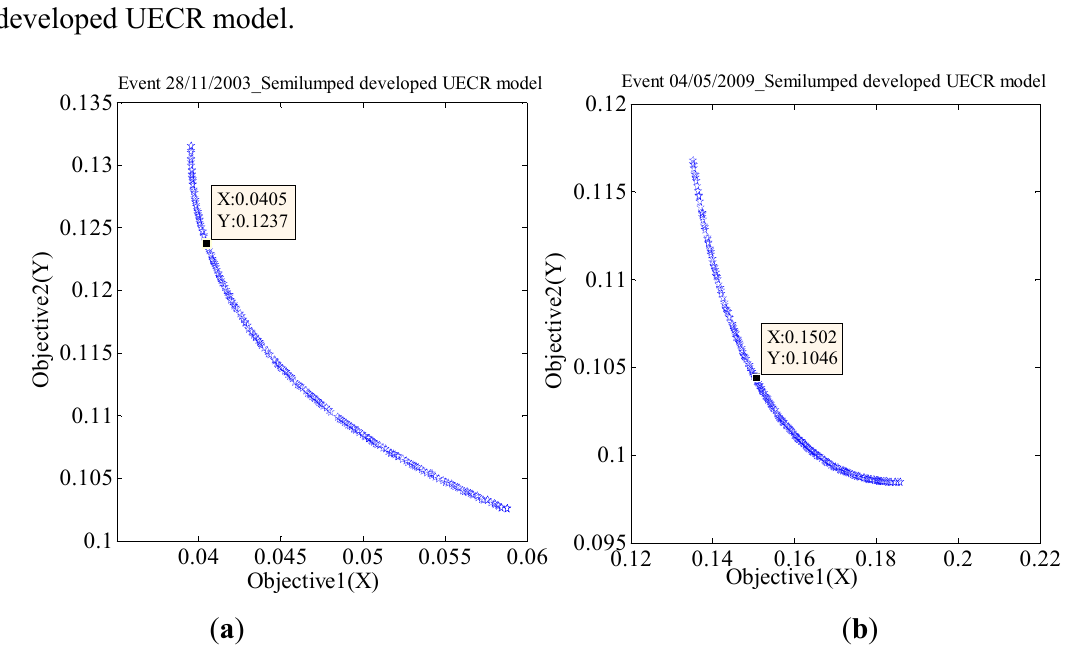
Figure 6. Pareto front and best compromise solution. ( a ) Event 28 November 2003_Semilumped developed UECR model; ( b ) Event 04 May 2009_seemilumped developed UECR